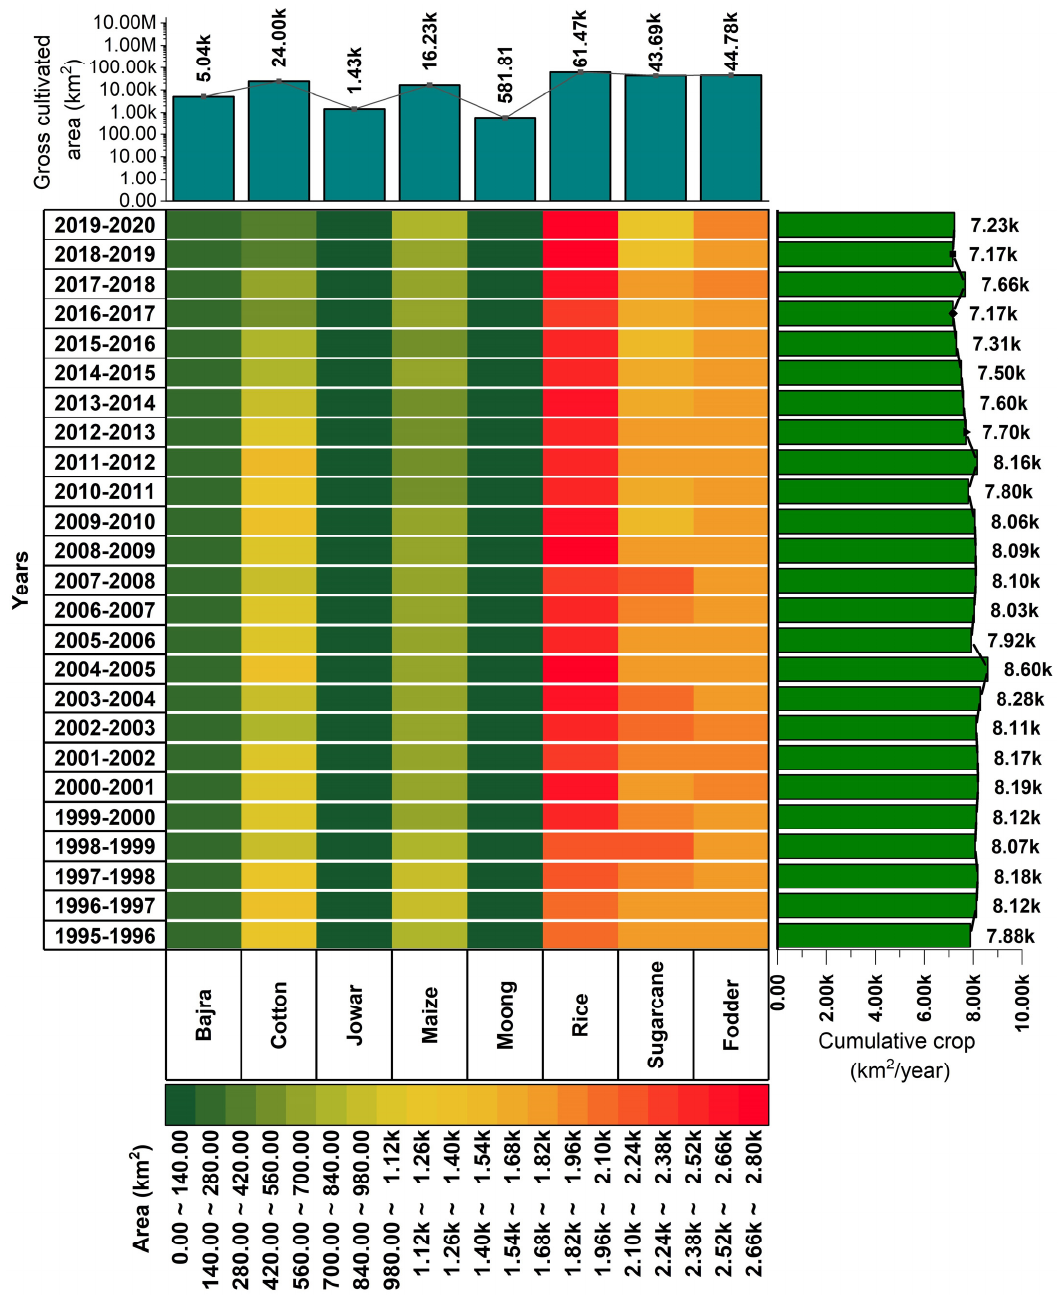
Figure 4. Shift in cropping pattern and cultivated area from 1995 to 2020 in kharif season.